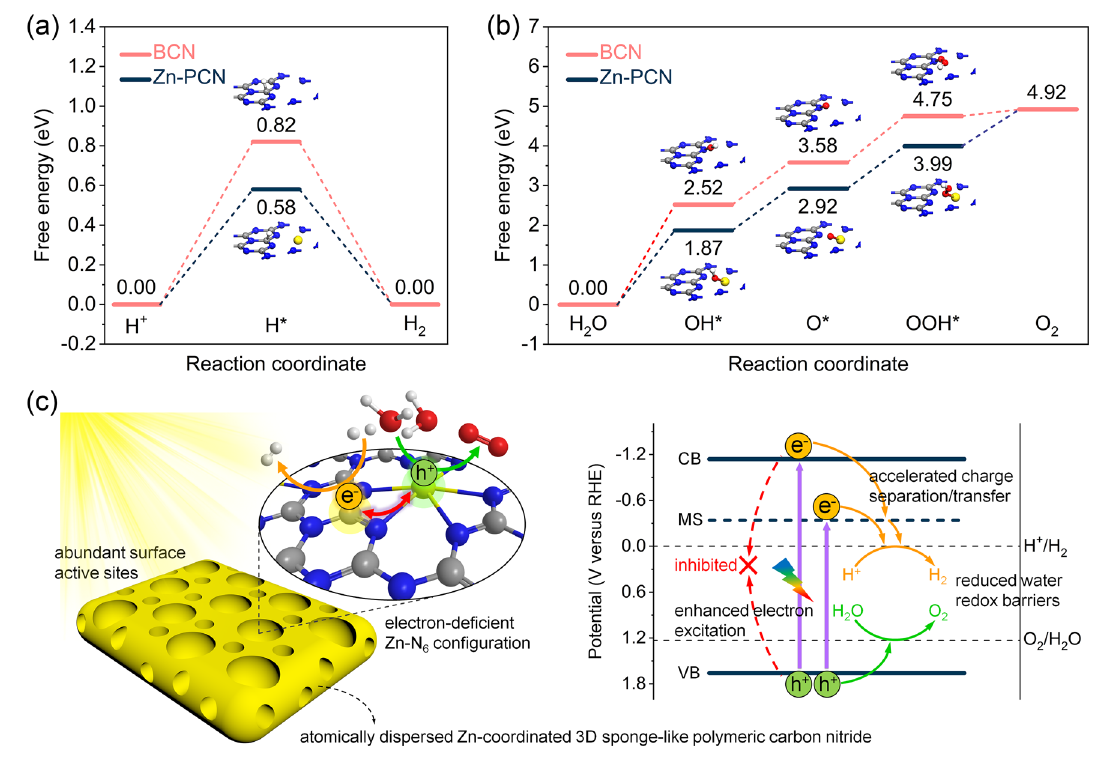
Fig. 6 Calculated free energy diagrams of a water reduction to H 2 and b water oxidation to O 2 for BCN and Zn‑PCN. c Proposed reaction mechanism of photocatalytic overall water splitting into H 2 and O 2 over Zn‑PCN. The gray, blue, yellow, red and white spheres represent the C, N, Zn, O and H atoms,